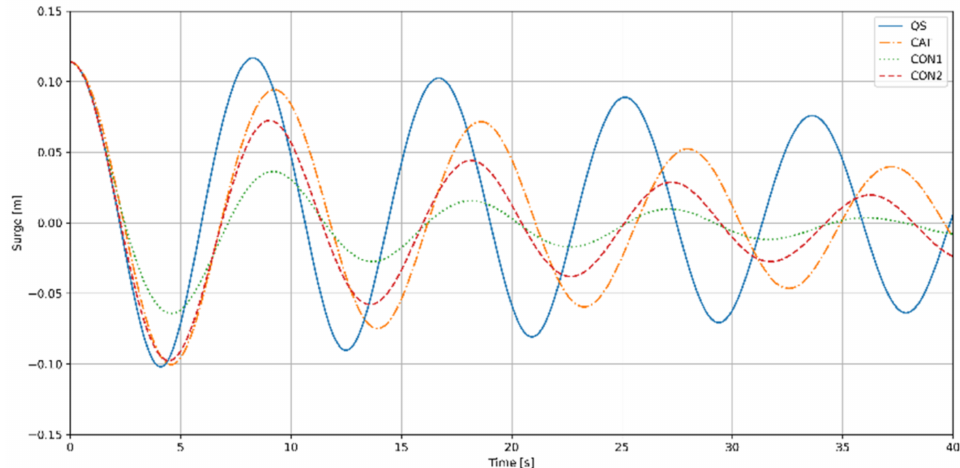
Figure 17. Comparative time histories of surge motion obtained from decay tests in surge.